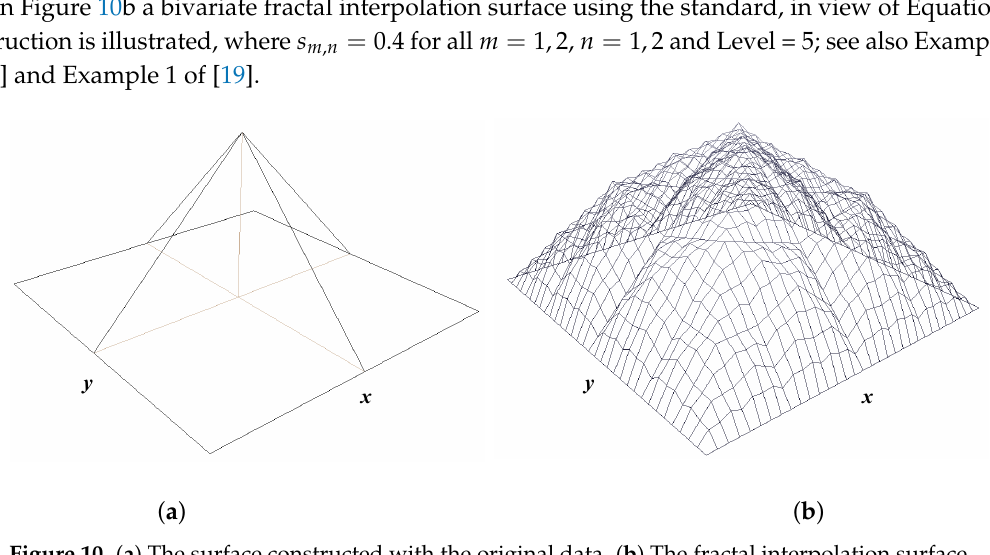
Figure 10. ( a ) The surface constructed with the original data. ( b ) The fractal interpolation